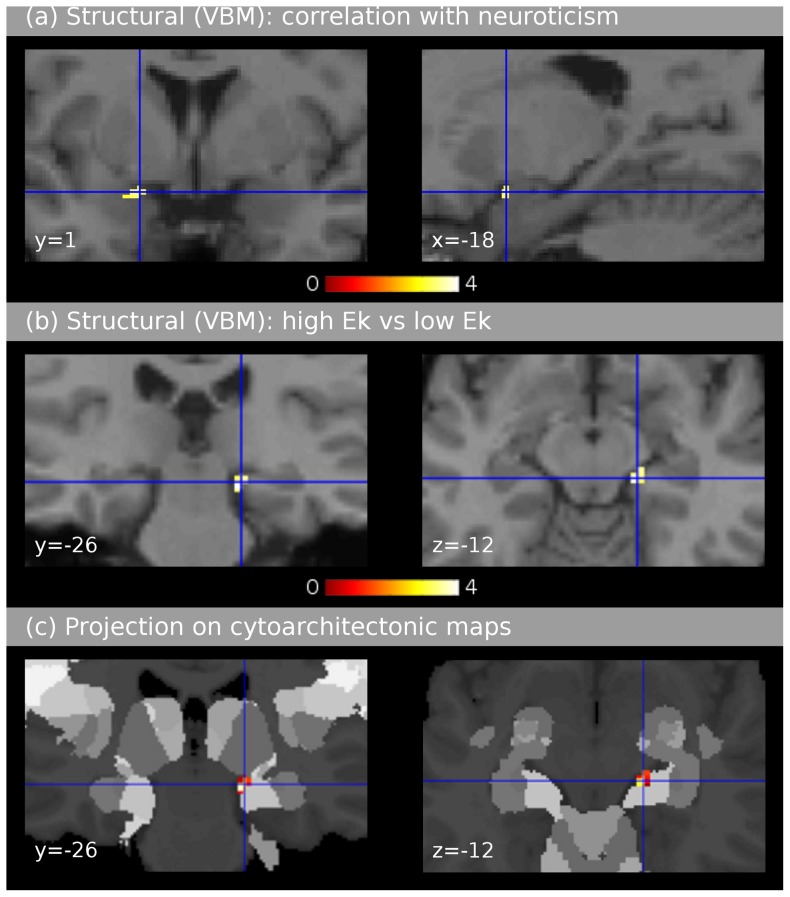
Experiment 2: Structural neuroimaging data (voxel-based morphometry).Results were controlled for total brain volume, age and gender, images are shown in neurological convention. The upper panel (a) shows results of the correlations of grey matter volume with neuroticism scores (uncorrected data with a threshold of p<.001 and a minimum cluster size of 10 voxels). The crosshair indicates a positive correlation in the left amygdaloid complex (significant in the region of interest analysis, p<.05, FWE-corrected). The left image shows a coronal section, the right image shows a sagittal section. The middle panel (b) shows the comparison of structural data between groups of participants with higher and lower E
κ values (uncorrected data with a threshold of p<.001 and a minimum cluster size of 10 voxels). A difference between groups was found in the subiculum of the right hippocampal formation (significant in the region of interest analysis, p<.05, FWE-corrected). Gray matter volume was larger in the group of participants with higher E
κ values (taken to reflect higher tender emotionality). Note the consistency with the group difference observed in the left subiculum in the functional data (Figure 2b). The left image shows a coronal section, the right image an axial section. The bottom panel (c) shows the same results as (b), projected on the cytoarchitectonic probability map of the hippocampal formation provided by Amunts et al. [78] using the Anatomy Toolbox provided by Eickhoff et al. [102]. The group difference is located with 90% probability in the subiculum.